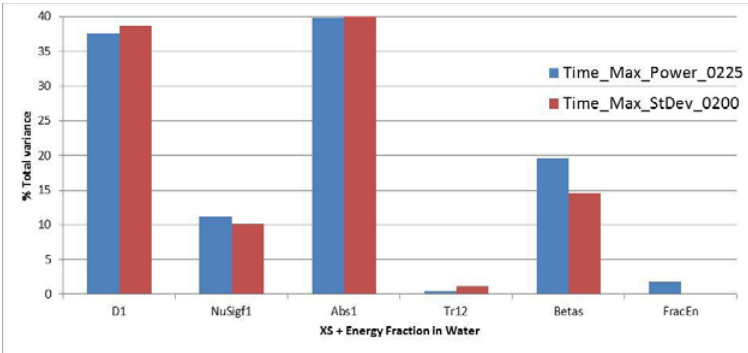
Figure 5: Cross Sections Variances on Total Variance (Power